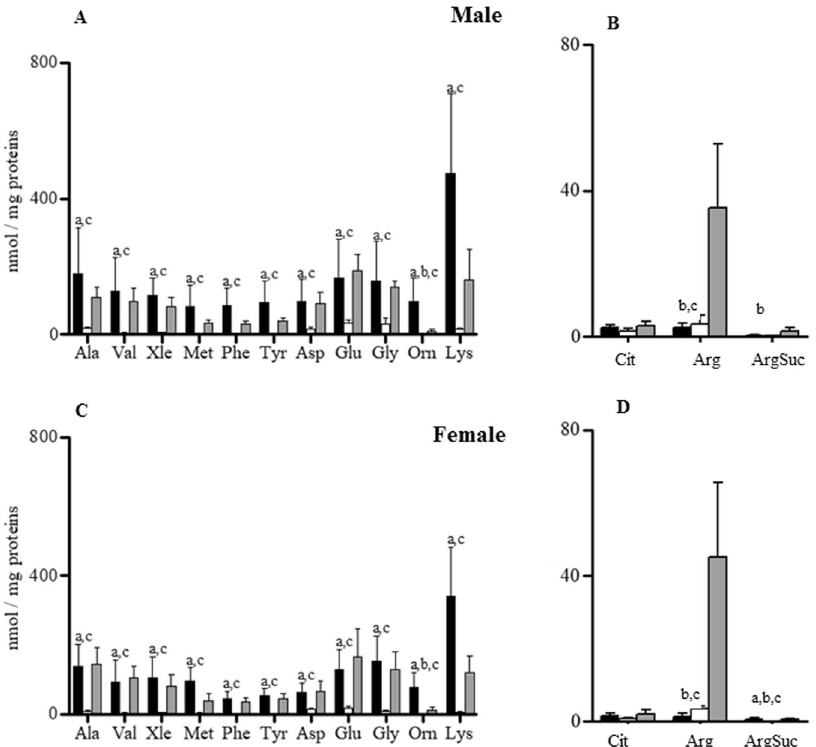
Figure 1. Intra-sex analysis of amino acids in livers (black bars), hearts (white bars) and kidneys (grey bars) of male (M) and female (F) rats. Data are the medians ± MAD of 15 samples for each tissue and sex. a P < 0.05 between liver and heart; b P < 0.05 between kidney and liver; c P < 0.05 between heart and